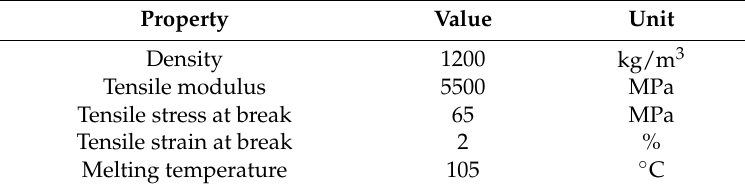
Table 2. Material properties of the investigated ABS-GF20 “Polyman FABS-20-GF/A. Schulman”